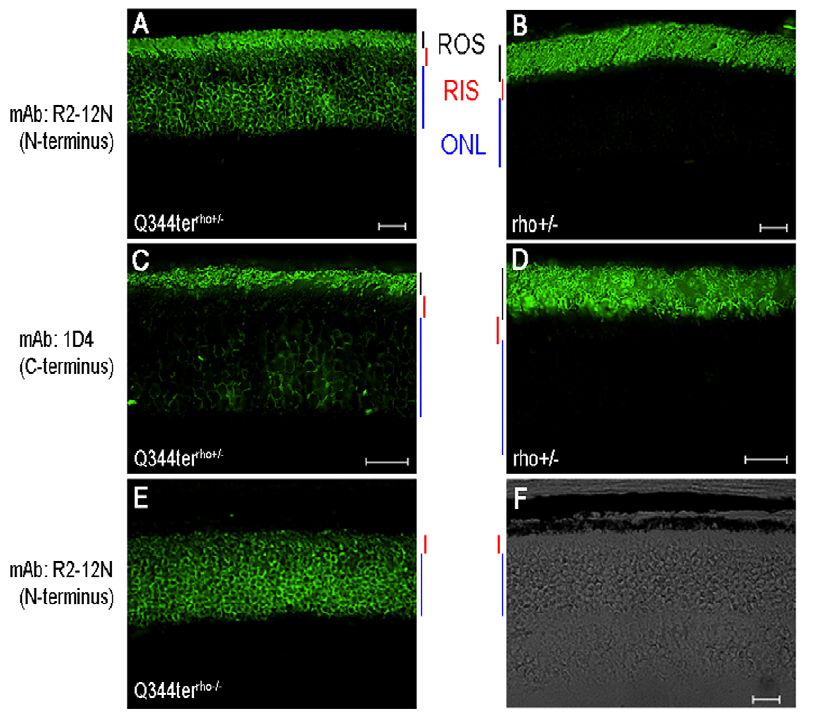
Figure 3. Q344ter rhodopsin is mislocalized and does not support ROS formation when expressed in the absence of endogenous rhodopsin. Q344ter rho + / 2 , Q344 rho 2 / 2 mice and their transgene negative littermate were dark-reared and sacrificed at p28–31. Frozen retinal sections immunostained with either the anti-N-terminal R2-12N ( A, B, E ), or the anti-C-terminal 1D4 ( C, D ) monoclonal antibodies against rhodopsin. R2-12N immunostaining was restricted to the rod outer segment (ROS) in control rho + / 2 sections (B), but extended to the rod inner segment (RIS) and outer nuclear layer (ONL) in Q344ter rho + / 2 sections (A). 1D4 immunostaining revealed the presence of endogenous rhodopsin in the ONL in Q344ter rho + / 2 retinas (C), which was not observed in retinas from negative transgene littermate controls (D). ROS structures were not detected in Q344ter rho 2 / 2 retinal sections when stained with R2-12N (E) or imaged by DIC microscopy ( F ). Scale bars =20 m m.